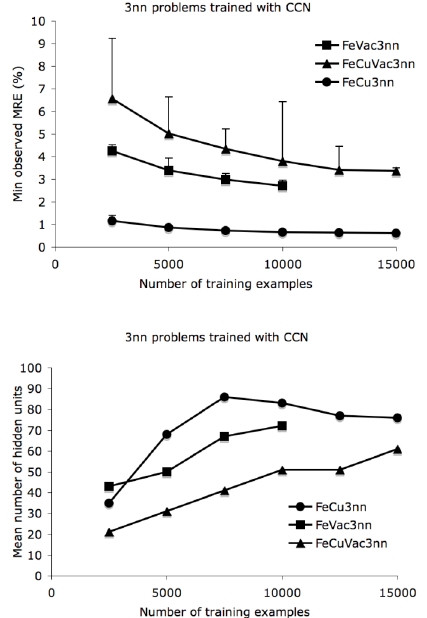
Fig. 13. Experiments with the 3nn